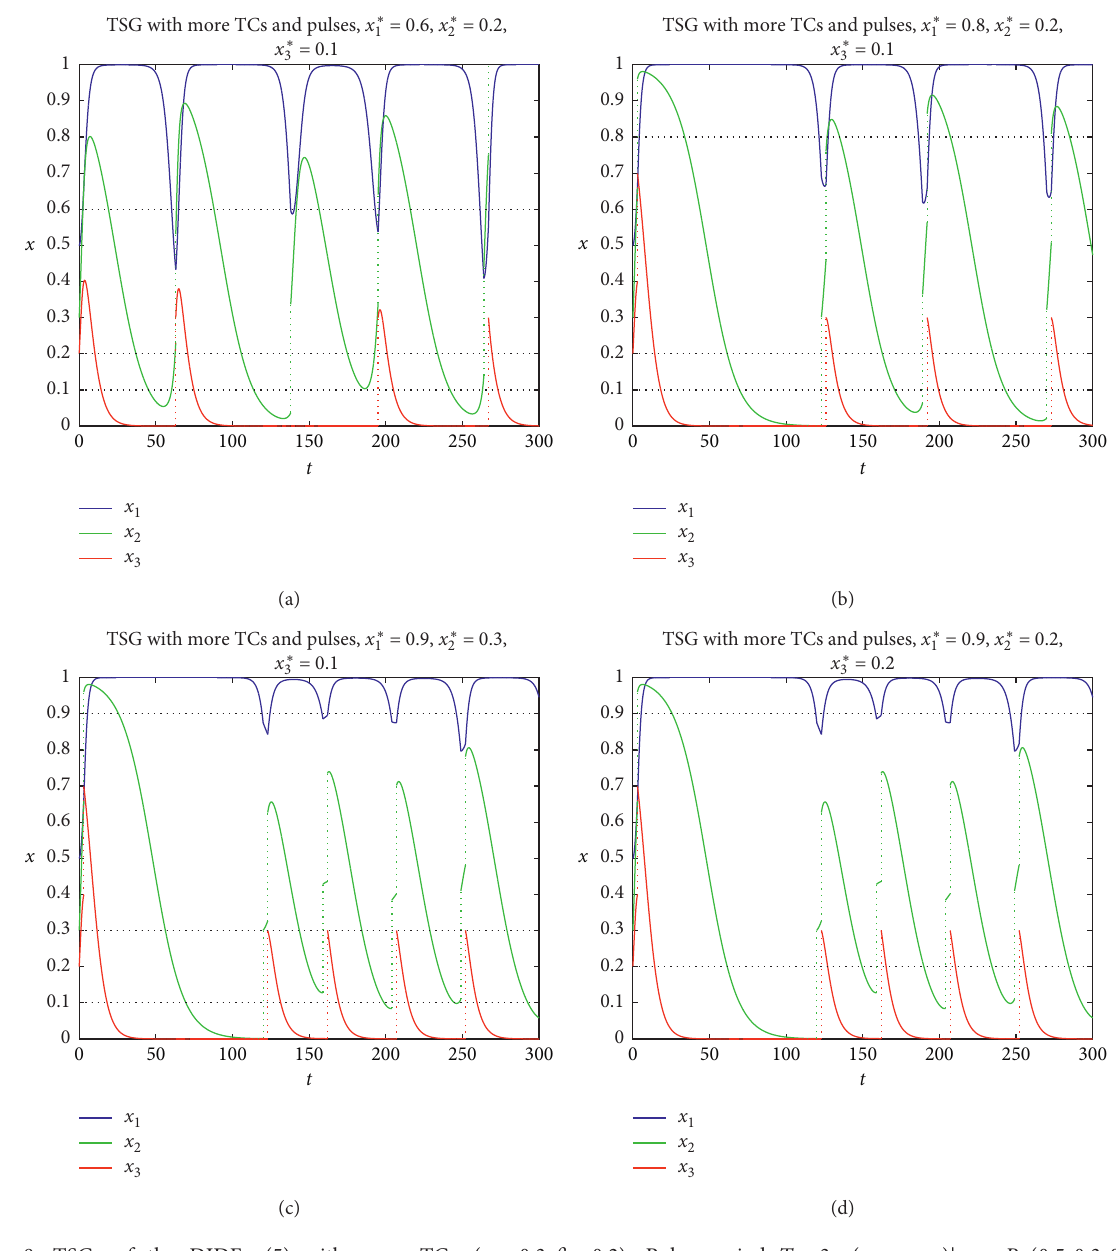
,x , x )| � P ( 0 . 5 , 0 . 3 , 0 . 2 ) . (a) t � 0 1 2 3 0